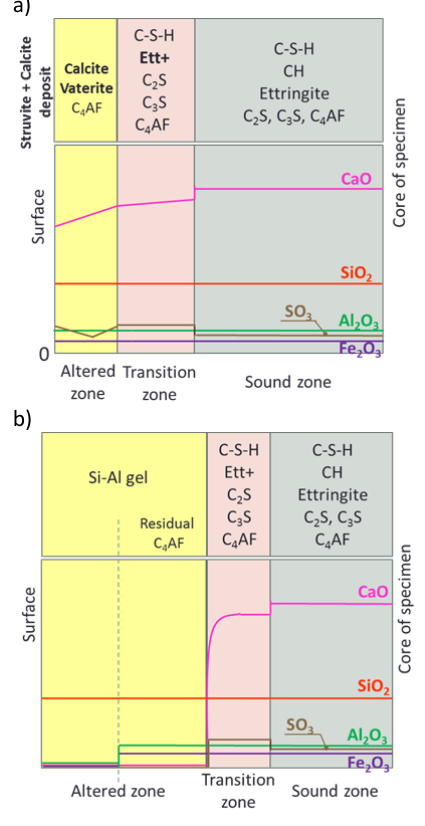
Figure 2. Typical mineralogical and chemical changes in CEM I cement paste specimen (W/C=0.27) exposed to a) liquid manure and b) whey (see main chemical conditions in text). This diagram synthetizes data from EPMA, XRD and SEM ‐ EDS analyses [5], [27]. Ett+: secondary non ‐ harmful ettringite precipitated in the transition zone. In the conditions of the experiments, the thickness of the altered and transition zones were 90  m and 120  m, respectively, for a) and 2000  m and 200  m, respectively, for b) after 4 weeks of exposure [9].